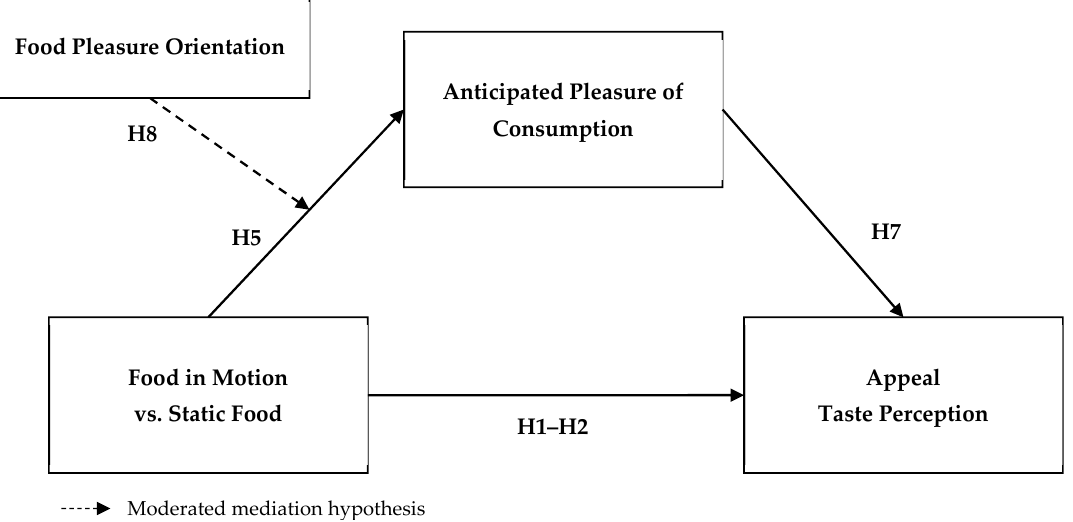
Figure 1. Conceptual model of the hypotheses (excluding some of the replication hypotheses).